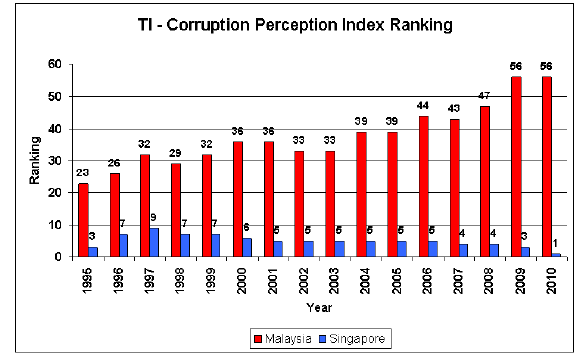
Figure 2. Example of political issue in Malaysia